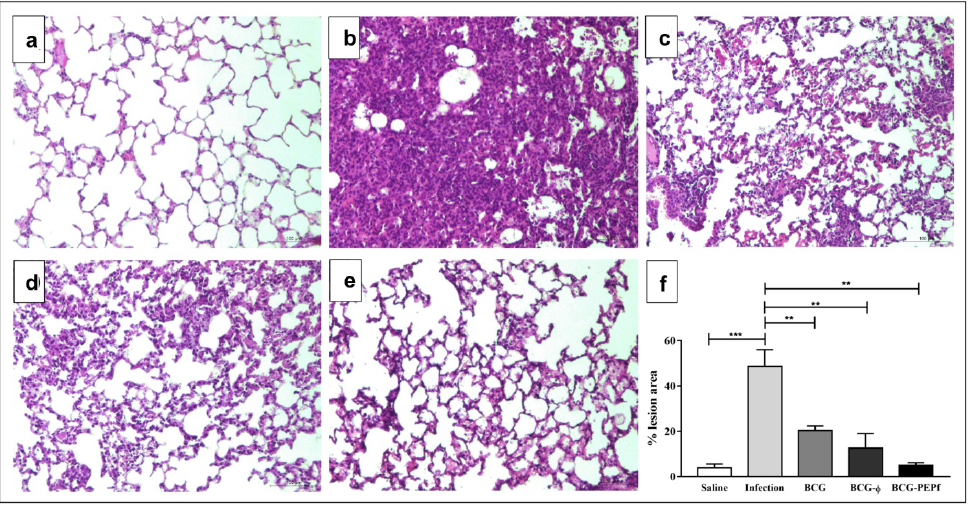
5, the BCG-PEPf vaccine failed to increase protection when compared to wt BCG.